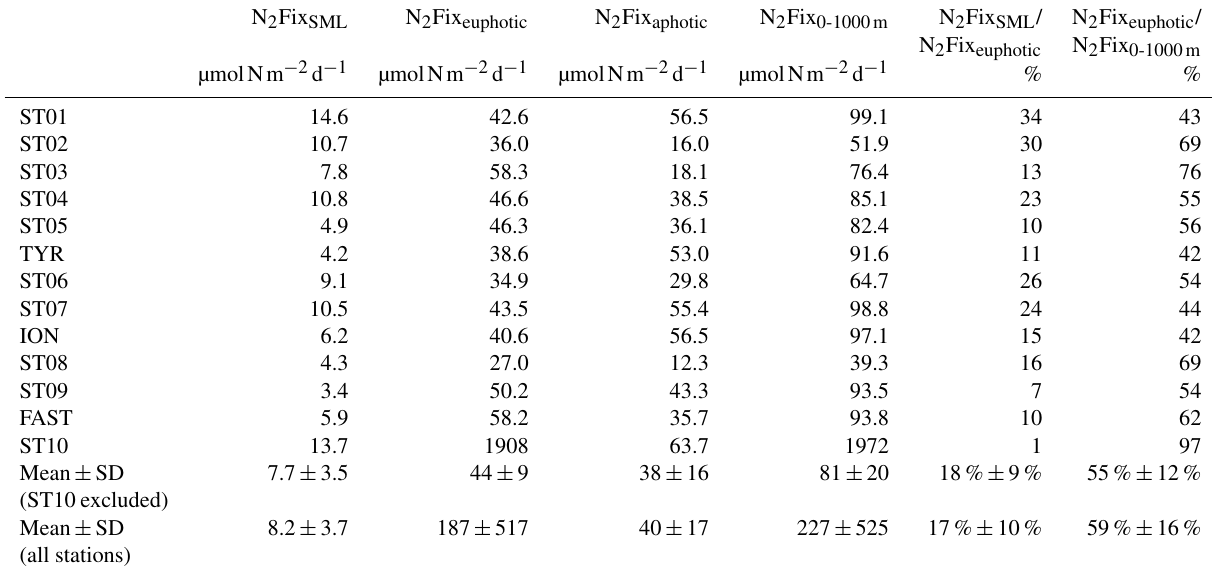
Table 1. Integrated N 2 fixation over the surface mixed layer (SML; from surface to the mixed layer depth), from the surface to the base of the euphotic layer (1%PAR depth), over the aphotic layer (1%PAR depth to 1000m) and from the surface to 1000m at all the sampled stations. Contribution (in percent) of SML-integrated N 2 fixation to euphotic-layer-integrated N 2 fixation and contribution of euphotic-layer- integrated N 2 fixation to total (0–1000m) integrated N 2